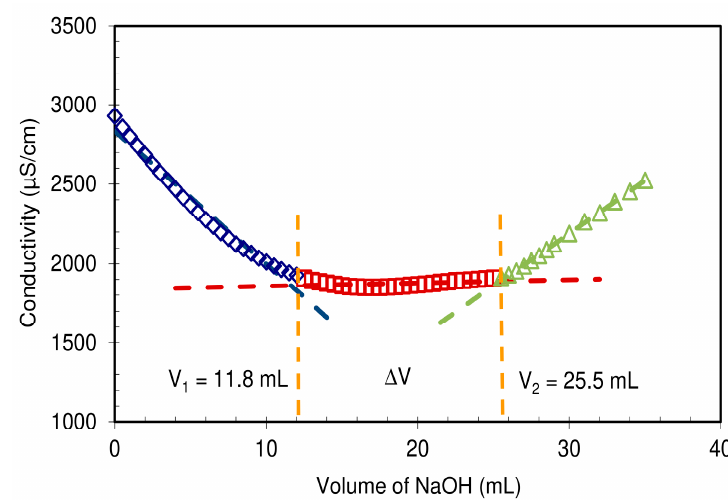
Figure 5. Outcome of conductimetric titration on a CMC-NFC suspension for determining the surface charge of the nanofibers.